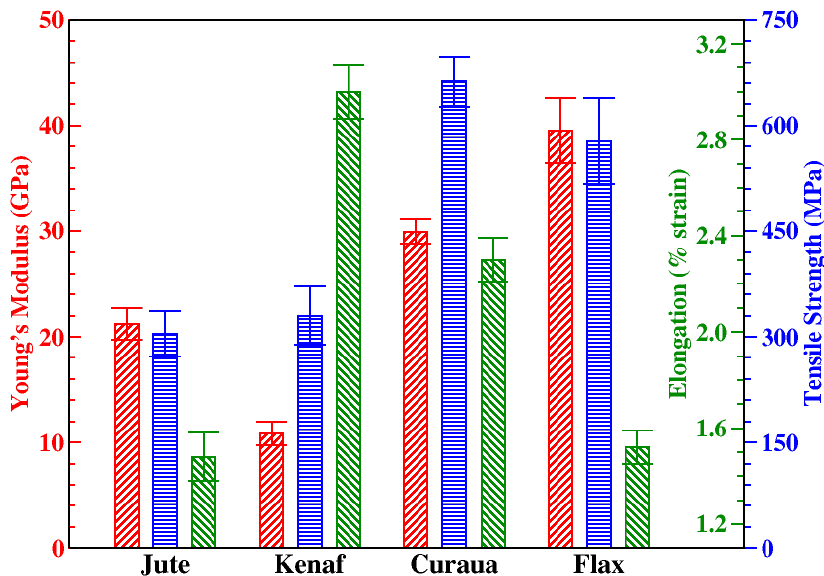
Figure 4. Young’s modulus (red /), tensile strength (blue − ), and elongation to break (green \) values of jute, kenaf, curaua, and flax